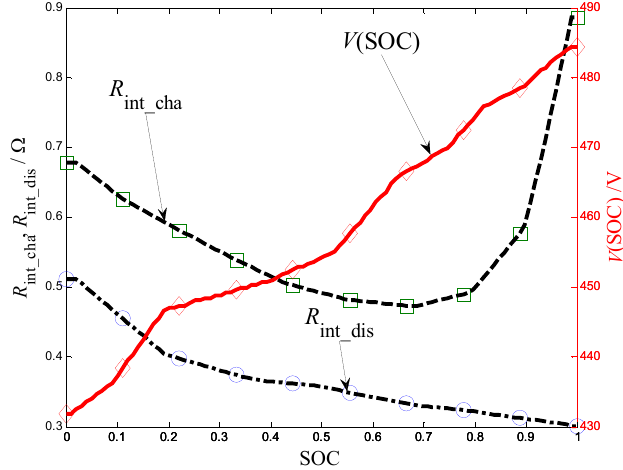
Figure 5. Battery open-circuit voltage and internal resistance obtained through experiments.